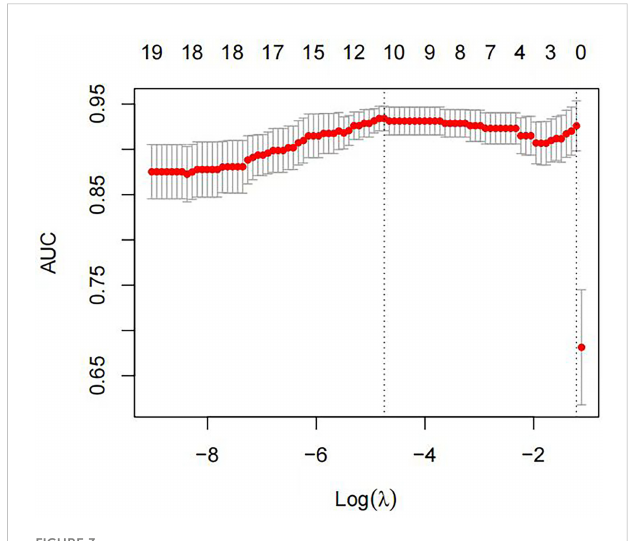
FIGURE 3 The optimal tuning parameter ( l ) was selected using ten-fold cross- validation with the LASSO regression model. The horizontal axis represents the log value of the best l , and the vertical axis represents the corresponding binomial deviation value. The red dots represent the average deviation of a given l value, the corresponding vertical line represents the upper and lower limits, and the dotted lines represent the selected optimal log( l ) values.